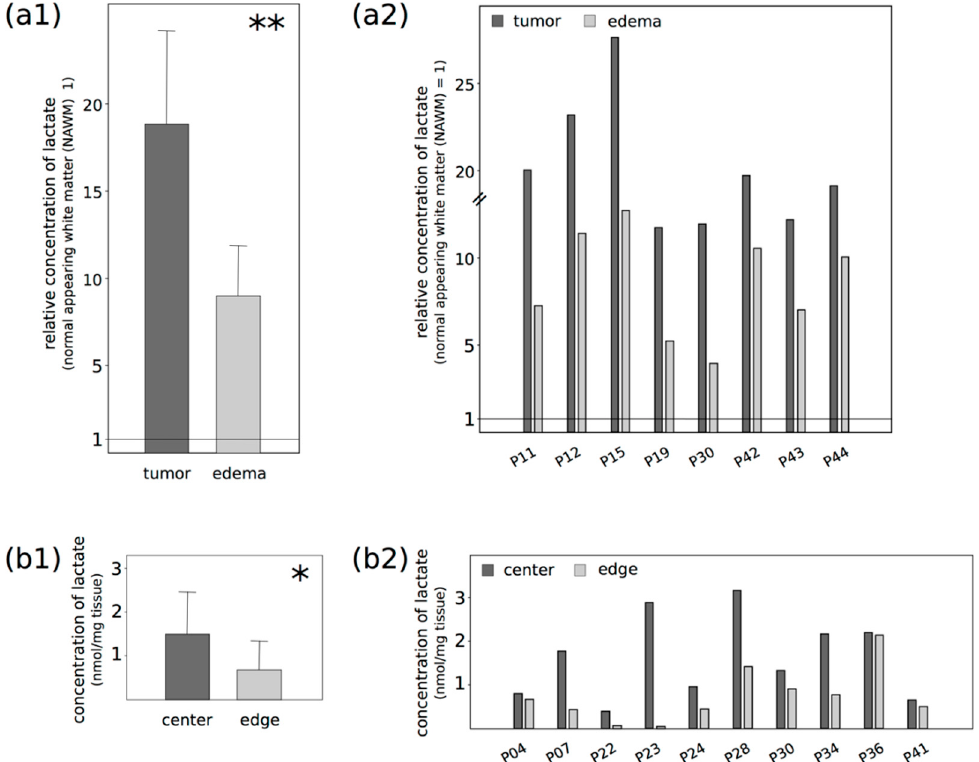
Figure 2. Comparison of lactate concentrations in different glioblastoma regions (P: patient/probe), as evaluated by ( a ) multi voxel magnetic resonance spectroscopic imaging (MRSI) and ( b ) lactate ELISA. ( a ) Based on the “normal appearing white matter (NAWM)” as reference (NAWM = 1), the relative lactate concentrations are given for the contrast-enhancing part of the tumor (“tumor”)—meaning in T1-weighted images after intravenous contrast agent injection—and for the edema without contrast enhancement (“edema”); ( b ) The lactate concentrations were determined in paired center and edge tumor samples and given as nmol/mg tissue. Both methods revealed a significantly different concentration of lactate comparing the examined regions. The relative lactate concentrations were significantly higher in the ( a ) contrast-enhancing part of the tumor than in the edema or the NAWM (** p : 0.006), and at the ( b ) tumor center compared with the edge (* p : 0.042). Statistically significant differences were determined by ( a ) one-way ANOVA or ( b ) two-tailed Student’s t -test. ( a1 ) and ( b1 ) show the average values of the determined concentrations, whereas ( a2 ) and ( b2 ) plot the values of each probe.